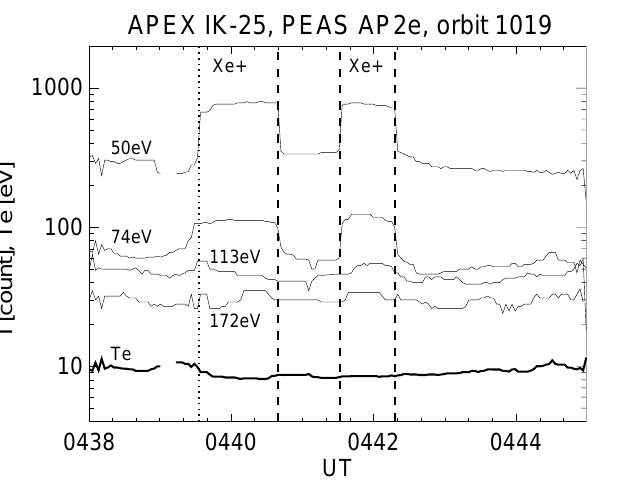
Fig. 6. Floating probe potential (vs s/c) during a sequence of neutral and ionized Xe plasma releases. From top to bottom: FP – floating probe potential, Ia – mean Xe plasma current, log ni – ambient plasma